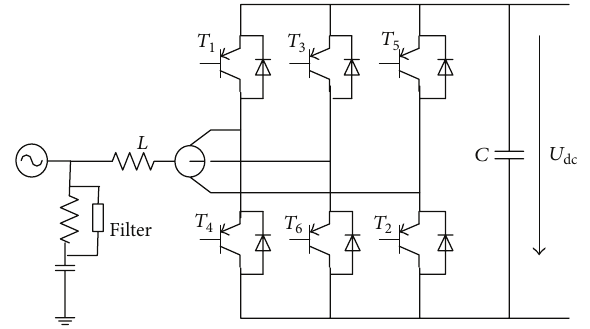
Figure 2: Topology diagram of VSC.